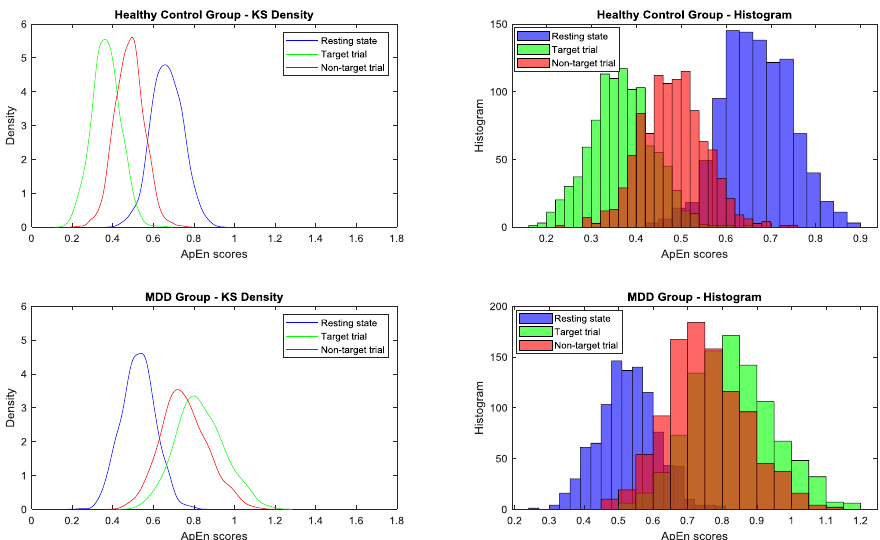
Figure 10. After 1000 bootstrapping simulations for each experimental condition, the kernel smoothing densities and histograms for four groups (from top to bottom: healthy control and MDD for three conditions) (blue: resting state; green: target trial; red: nontarget trial) are plotted. Table 5. One-way ANOVA results of mean di ff erences and its 95% confidence intervals in the approximate entropy among